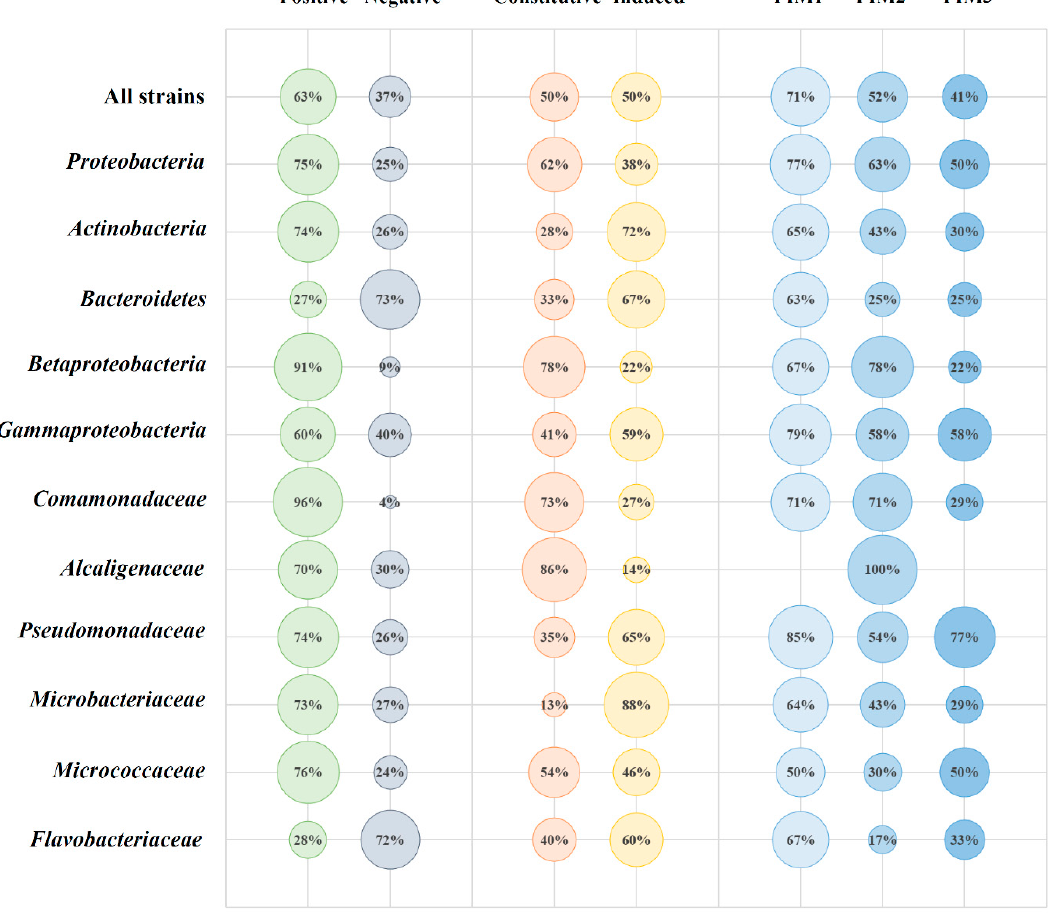
Figure 5. Percentage of strains (total and within selected taxonomic ranks) expressing the following traits: Positive—presence of red-fluorescing granules (on R3A broth and on PIMs); negative—absence of red-fluorescing granules in any conditions; constitutive—presence of red-fluorescing granules in R3A broth; induced-presence of red-fluorescing granules only after incubation in PIMs; PIM1—presence of red-fluorescing granules after incubation in PIM1 within the “Induced” group; PIM2—presence of red-fluorescing granules after incubation in PIM2 within the “Induced” group; PIM3—presence of red-fluorescing granules after incubation in PIM3 within the “Induced”